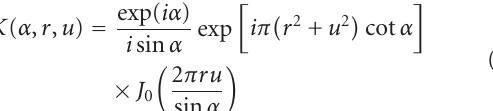
and R π , two F F